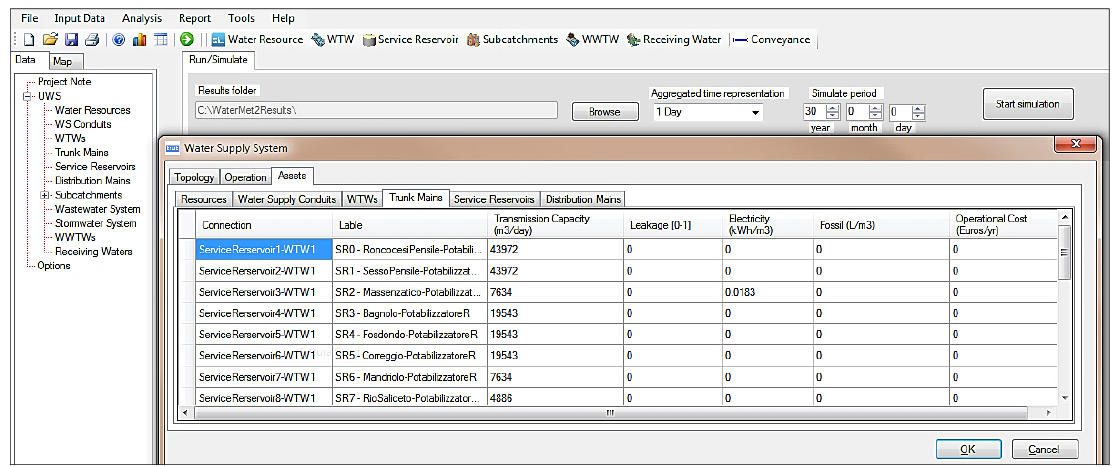
Figure 1. WaterMet 2 interface: on the left, the main tabs available in the model, each one defining a component of the UWS. In the centre, the Trunk Main tab, where the main features are